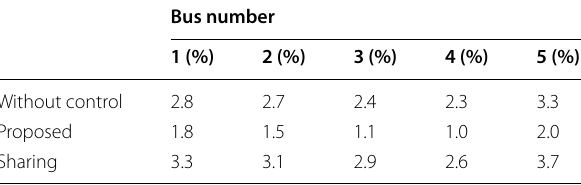
Table 5 The unbalance factor of each bus in the simulation.